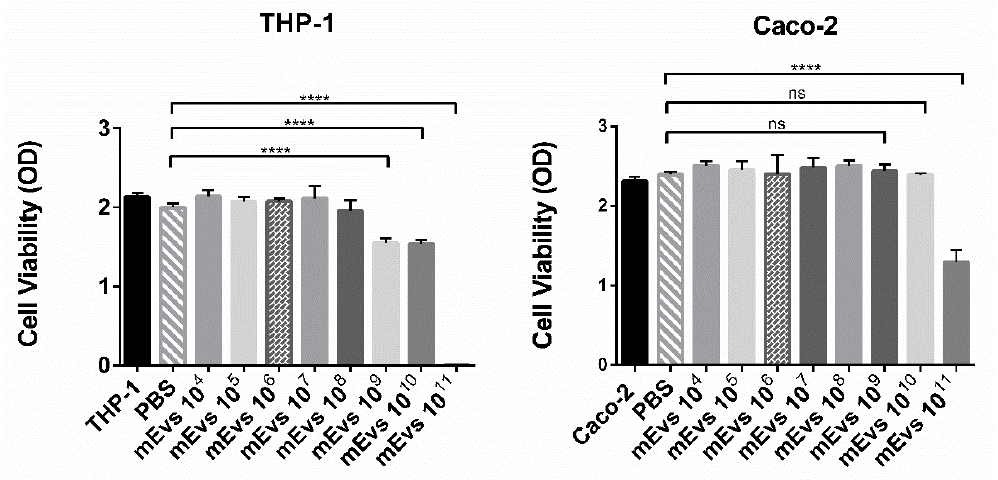
Figure 3. The 3-(4,5-dimethylthiazol-2-yl)-5-(3-carboxymethoxyphenyl)-2-(4-sulfophenyl)-2H-tetrazolium, inner salt (MTS) cell viability assay. Twenty-one (21) days differentiated Caco-2 cells and THP-1 cells were seeded in a 96-well plate in the absence and presence of different amounts of mEVs from 1 × 10 4 to 1 × 10 11 . Cells were incubated for 48 h at 37 ◦ C under 5% CO 2 . After 2 h incubation with MTS reagent, absorbance at 490 nm was measured using a microplate reader. The data are representative of 3 independent experiments. **** p < 0.0001, ns p > 0.05. This different effect of 10 10 and 10 9 mEVs concentrations on Caco-2 and THP-1 cells viability can be explained by considering the different amounts of plated cells. In fact, after 21 days of differentiation, the Caco-2 cells number is greater than 0.1 × 10 6 THP-1 cells plated the day before the experiment. Based on this result, to further analyze the effect of mEVs in modulating the inflammation in the co-culture model reported in this work, two different concentrations were used: 10 8 and 10 10 . The first one had no cytotoxic effect on both cell lines, while 10 10 , although it caused a THP-1 viability reduction, probably induced a better modulation of inflammation in Caco-2 cells. We performed a cell viability assay by quantification of LDH release to evaluate a possible mEV cytotoxic effect on THP-1 and/or Caco-2 cells and, at the same time, demonstrate effective damage on the cell membrane due to the inflammation treatment (C1). The LDH release in Caco-2 or THP-1 monocultures was used as the baseline, while C0 was used as control of a stable co-culture. After the inflammation establishment (C1) and the 24 h mEV treatment (C2a and C2b), 50 µ L of cell-free supernatant was removed from every sample from the BL compartment to evaluate the LDH release from THP-1 cells and from the AP compartment to evaluate the Caco-2 damage. In Figure 4, the cytotoxicity percentage is reported, according to datasheet instruction from the CyQUANT LDH kit. In detail, the ratio is expressed as a release of LDH amount normalized to maximum LDH release in the monoculture. The reported data for both cell lines showed a significant increase in the LDH release in the C1 condition compared to C0 and no significant LDH release in Caco-2 monoculture. About THP-1 cells, the cell damage reported could be due to PMA treatment. However, it is worth noticing that there was no significant increase in LDH release, and consequently cell damage, when mEVs were administered to the co-culture, confirming the absence of a cytotoxicity effect of the mEVs even at 10 10 .